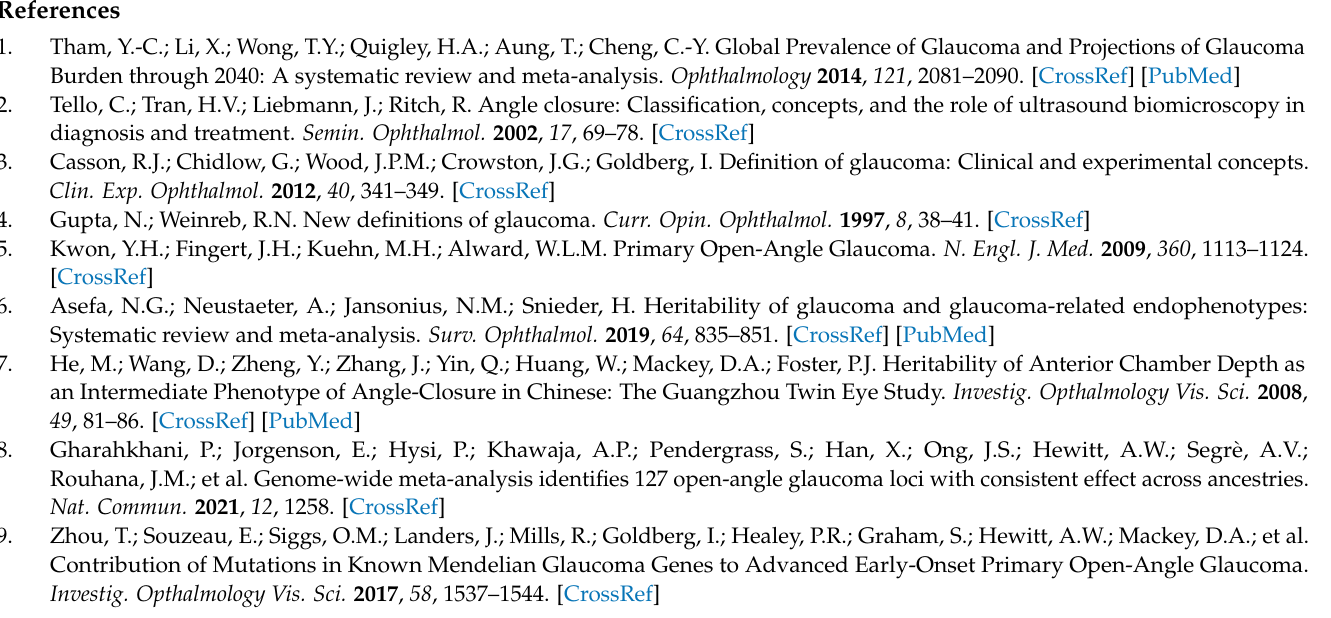
Table S2: Known gene variations in the studied families. Table S3: Exome coverage for samples. Table S4: Candidate SNVs in glaucoma families. Table S5: Candidate indels in glaucoma families. Table S6: Prioritised variant genotyping analysis. Table S7: Gene mutations in sporadic glaucoma cases. Table S8: GEO studies used for differential analysis from bulk tissues. Table S9: Candidate genes with differential expression in GEO studies. Table S10: Single-cell expression studies used and analysis of result. Table S11: The transcription factors and the pathways enriched by the candidate genes. Table S12: Primer sequences used for validation in the